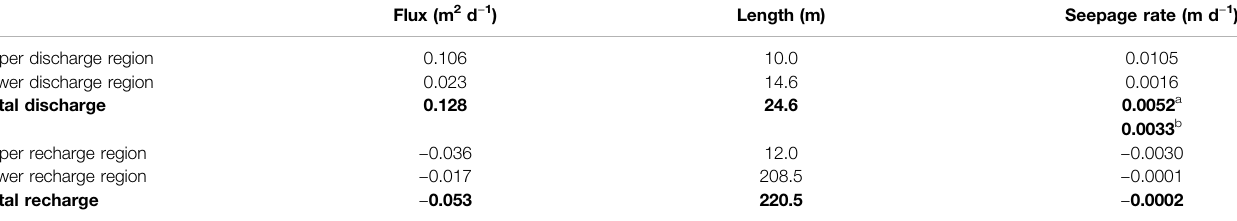
TABLE 3 | Fluxes across speci fi c discharge and recharge regions of the reference peatland. Total discharge/recharge fl ux, length, and seepage rate are highlighted in